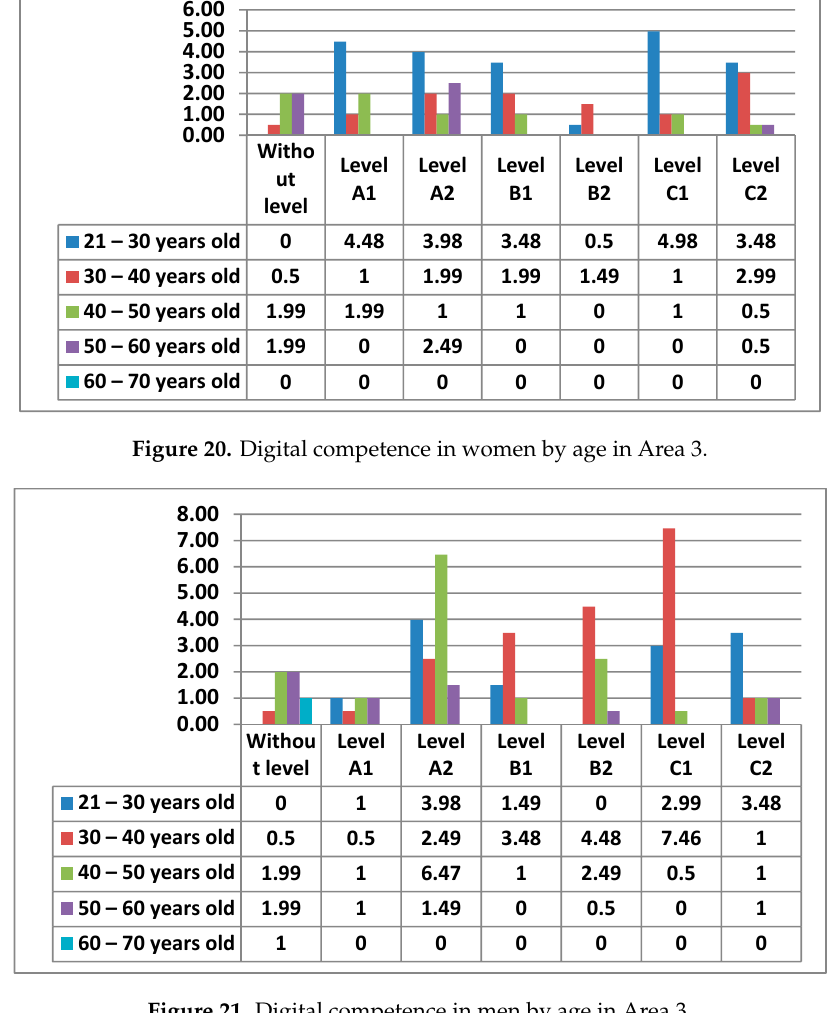
Figure 21. Digital competence in men by age in Area 3.